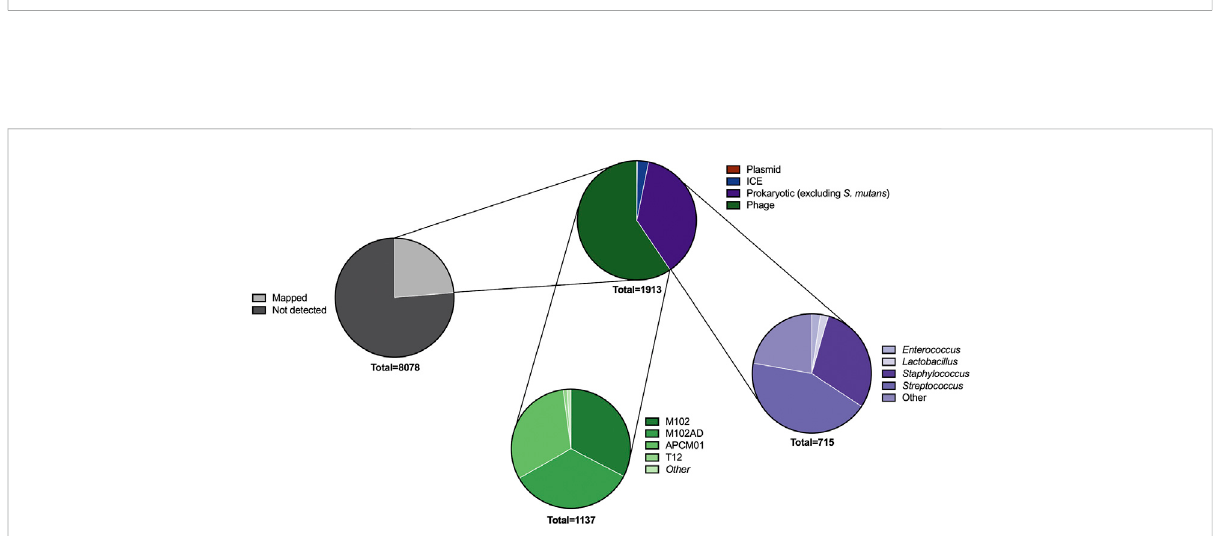
FIGURE 2 Predicted targets of CRISPR spacers. A series of pie charts shows the targets of spacers after searching across viral, plasmid, integrative and conjugative element, and bacterial DNA databases. The types of bacterial and phage DNA being targeted were further classi fi ed into genus (for bacteria) andstrain (phage).These targets arenot unique; for example,many oftheCRISPRspacers targeting phage will target multiplephagesifthe phage gene is